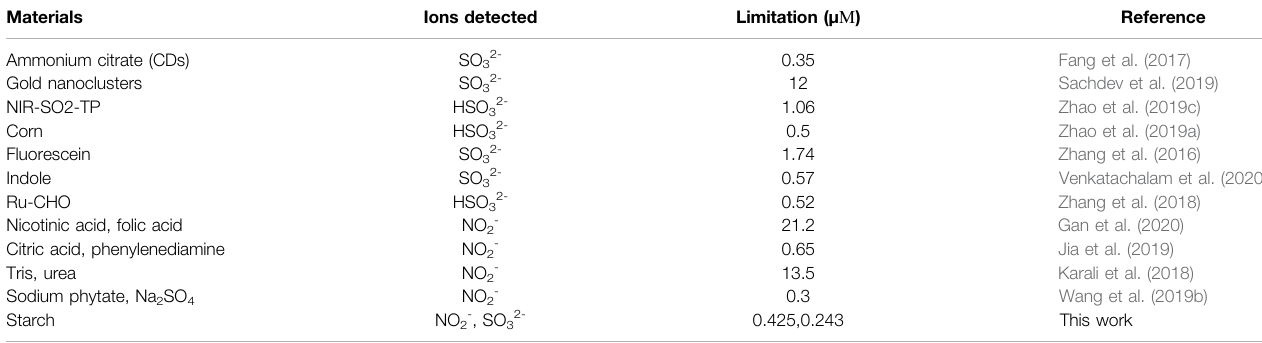
TABLE 1 | Performance comparison of different fl uorescence probes for the detection of SO 32- and NO 2- Materials